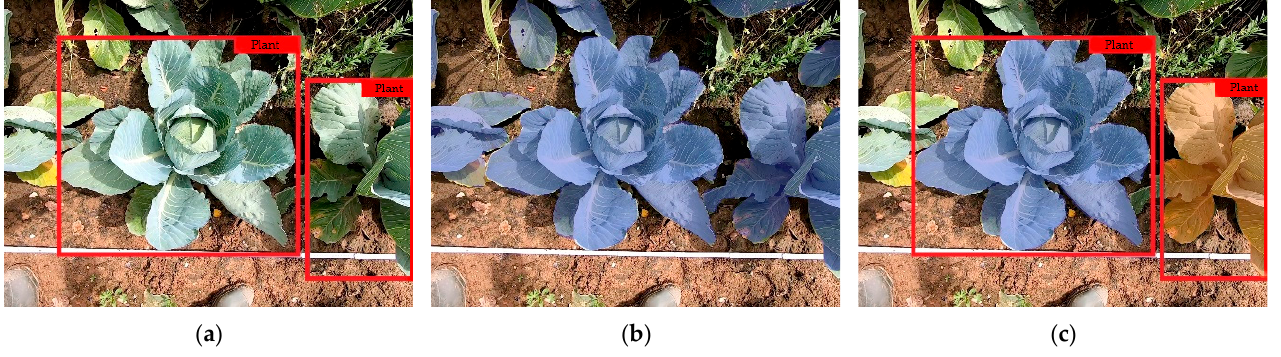
Figure 3. Examples of object detection by a bounding box ( a ), semantic segmentation ( b ), and instance segmentation ( c ) .